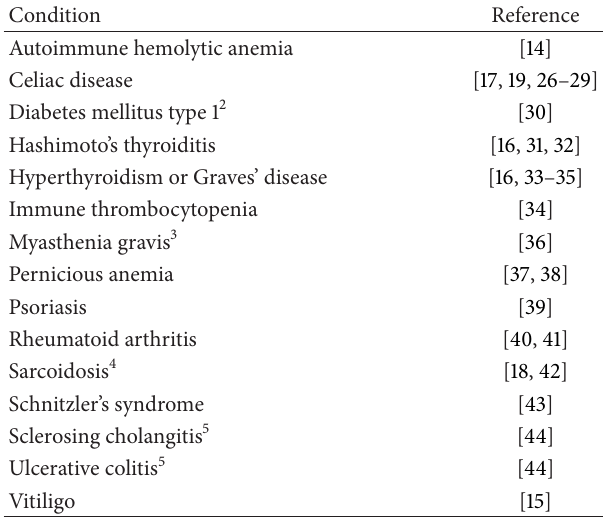
Table 4: Autoimmune conditions previously reported in persons with hemochromatosis 1